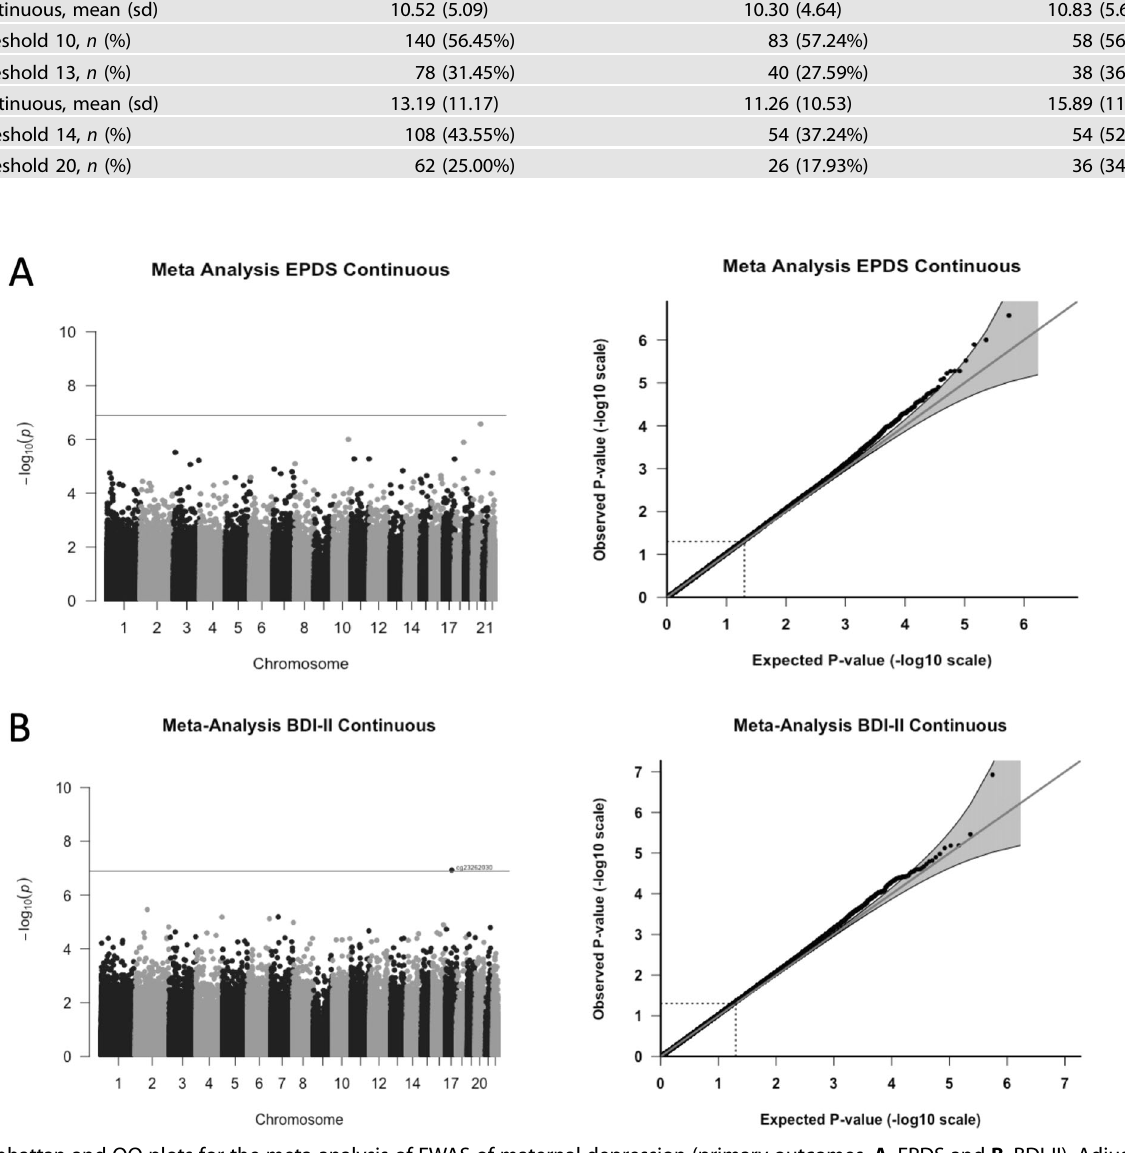
Fig. 1 Manhattan and QQ plots for the meta-analysis of EWAS of maternal depression (primary outcomes, A . EPDS and B . BDI-II). Adjusted for covariates: mother ’ s smoking status, average household income, child ’ s sex, gestational age at birth, fi rst three cell type PCs, and fi rst fi ve genotype PCs. Unmeasured confounding and bias were adjusted with Cate and Bacon R packages. Bonferroni threshold: meta-analysis = 1.29 × 10 − 7